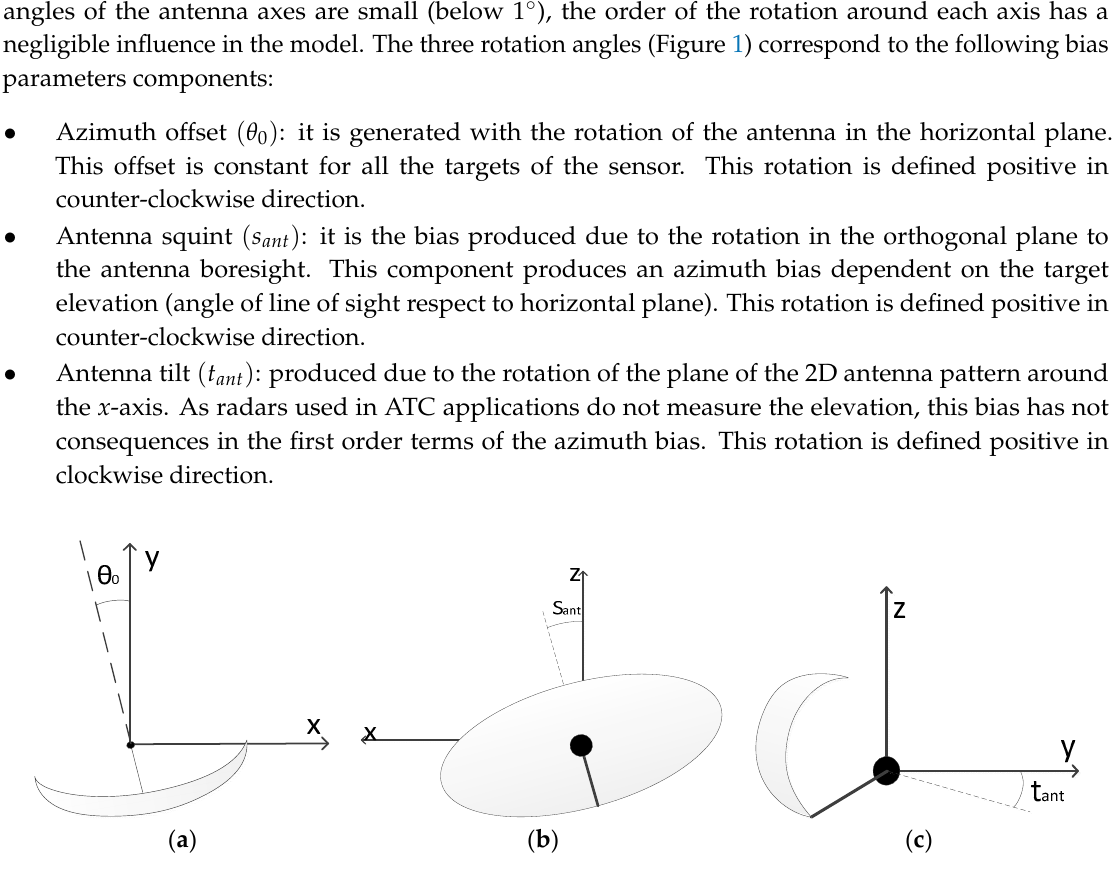
Figure 1. Representation of: ( a ) antenna azimuth offset, ( b ) antenna squint ( c ) and antenna tilt. The rotation matrix for each one of the axes are: